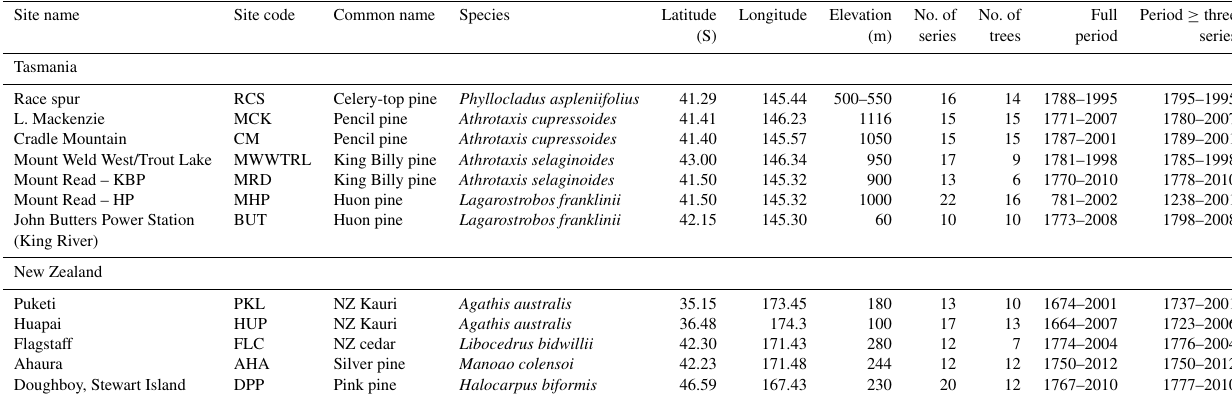
Table 1. Chronology information for the seven Tasmanian and five New Zealand sites used in the study (see Fig.